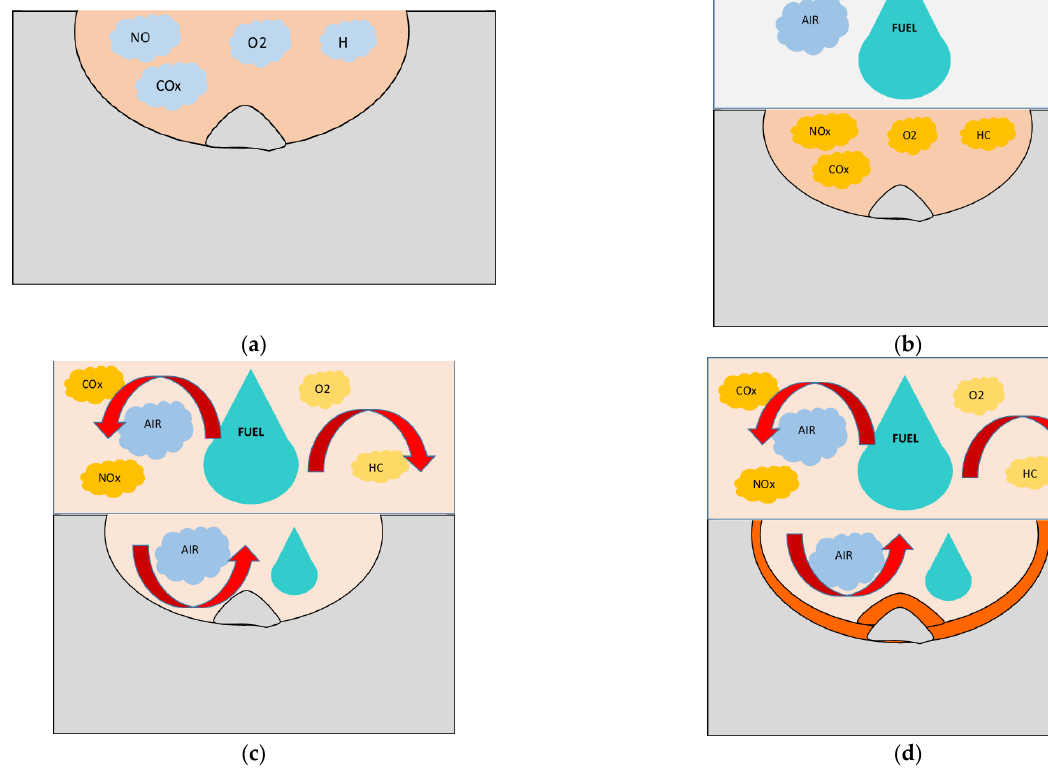
Figure 10. Staged combustion concept: ( a ) primary combustion, ( b ) introduction of subsequent fuel, ( c ) heated subsequent fuel and blend with previous traces product of combustion, ( d ) staged combustion of ( c ).